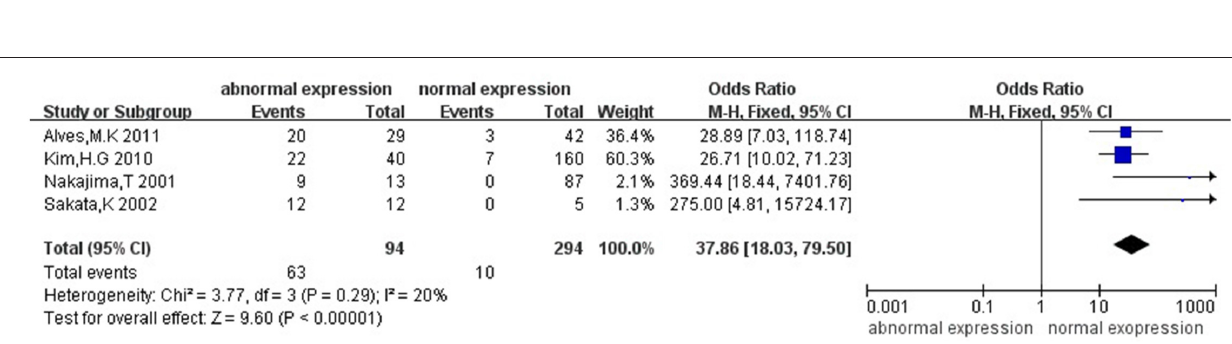
FIGURE 6 | Forest plot concerning hMLH1 methylation and Helicobacter pylori infection. HP, Helicobacter pylori. Fixed-effect model was used.